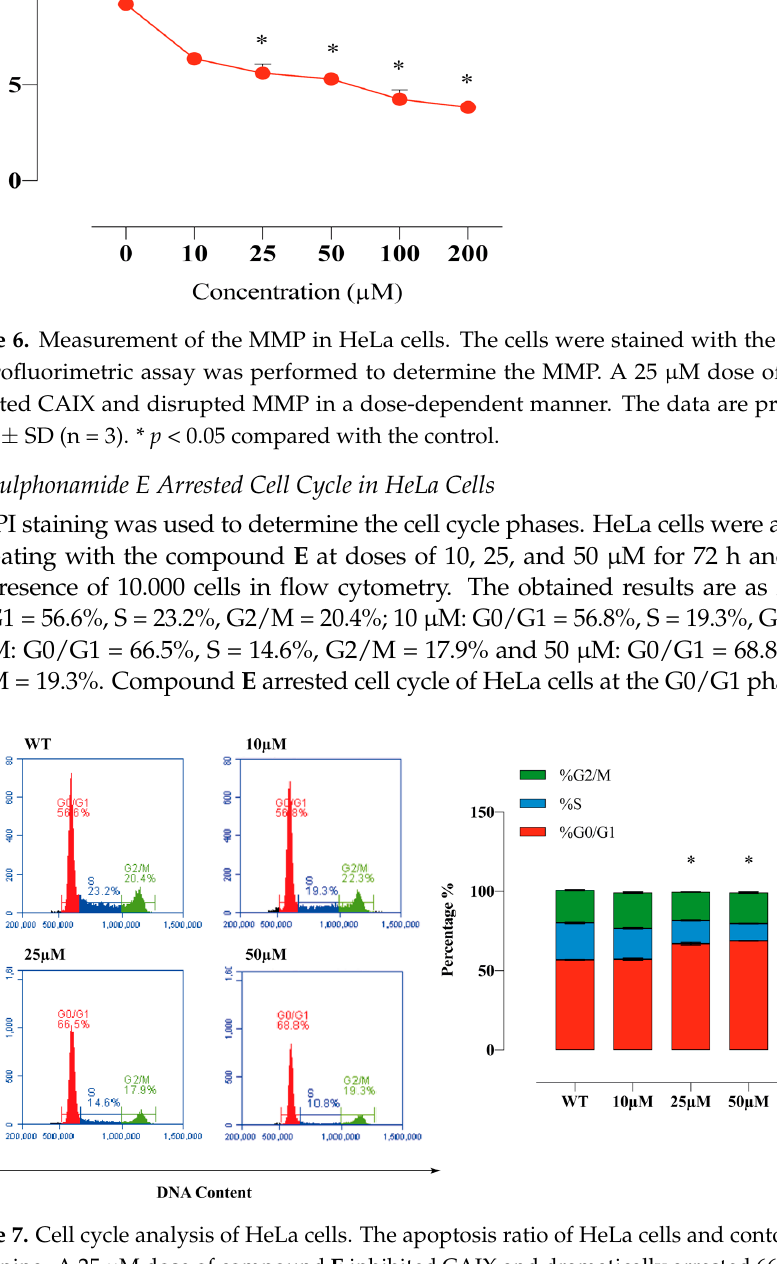
Figure 7. Cell cycle analysis of HeLa cells. The apoptosis ratio of HeLa cells and contour diagram of PI staining. A 25 µM dose of compound E inhibited CAIX and dramatically arrested 66.5% of the cells at G0/G1 phase. All data are expressed as mean ± SD values from three independent experiments. * p < 0.05 compared with the control (WT: Wild Type).